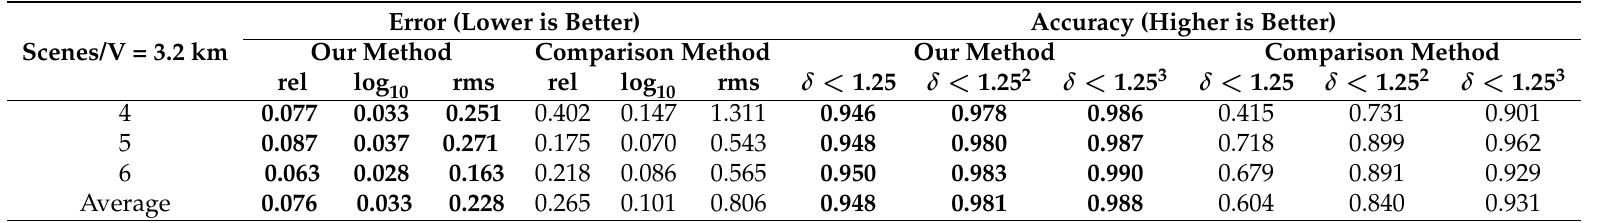
Table 2. Error and accuracy metrics of the first quantitative comparison method (V = 3.2 km).